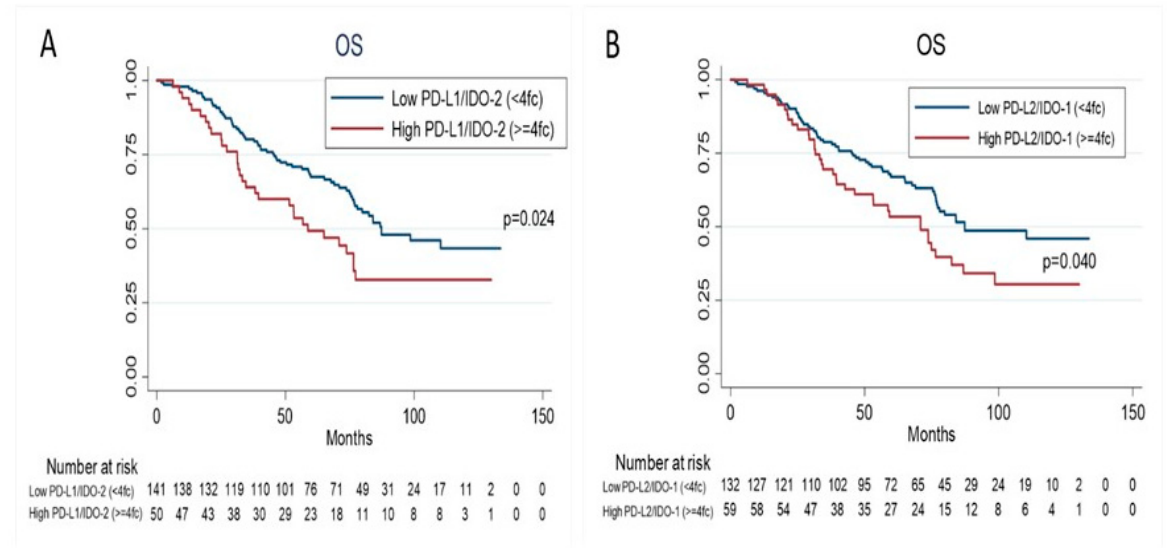
Figure 3. Kaplan–Meier estimates for overall survival (OS) according to PD-L1/IDO-2 co-expression levels ( A ), and PDL-2/IDO-1 co-expression levels ( B ).